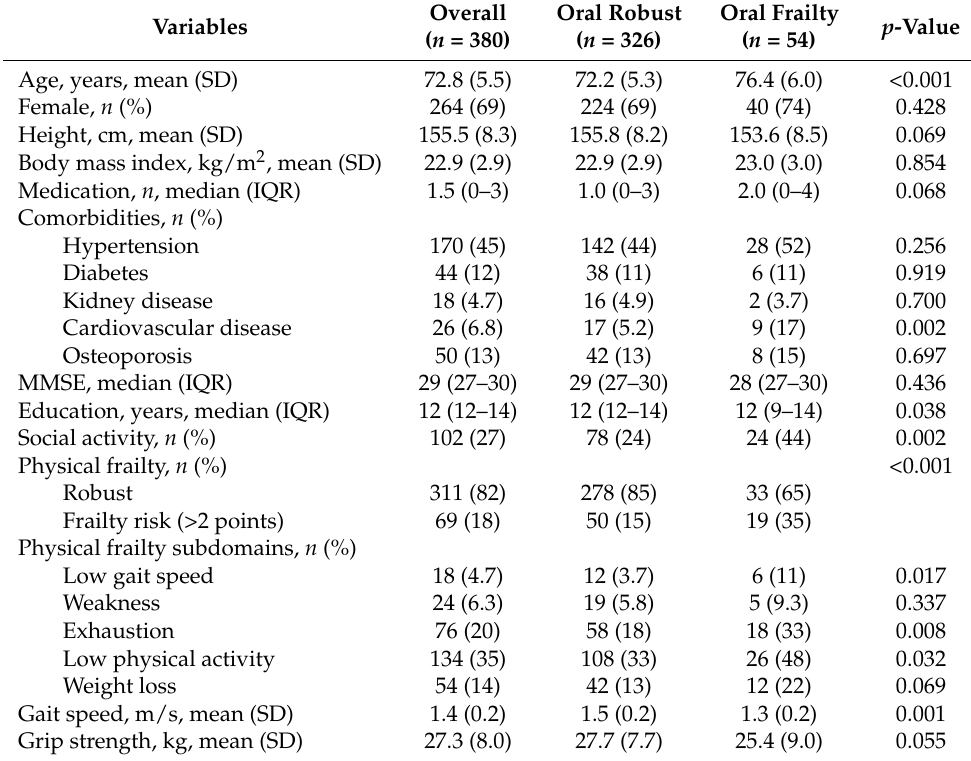
Table 1. Characteristics in participants with oral frailty.